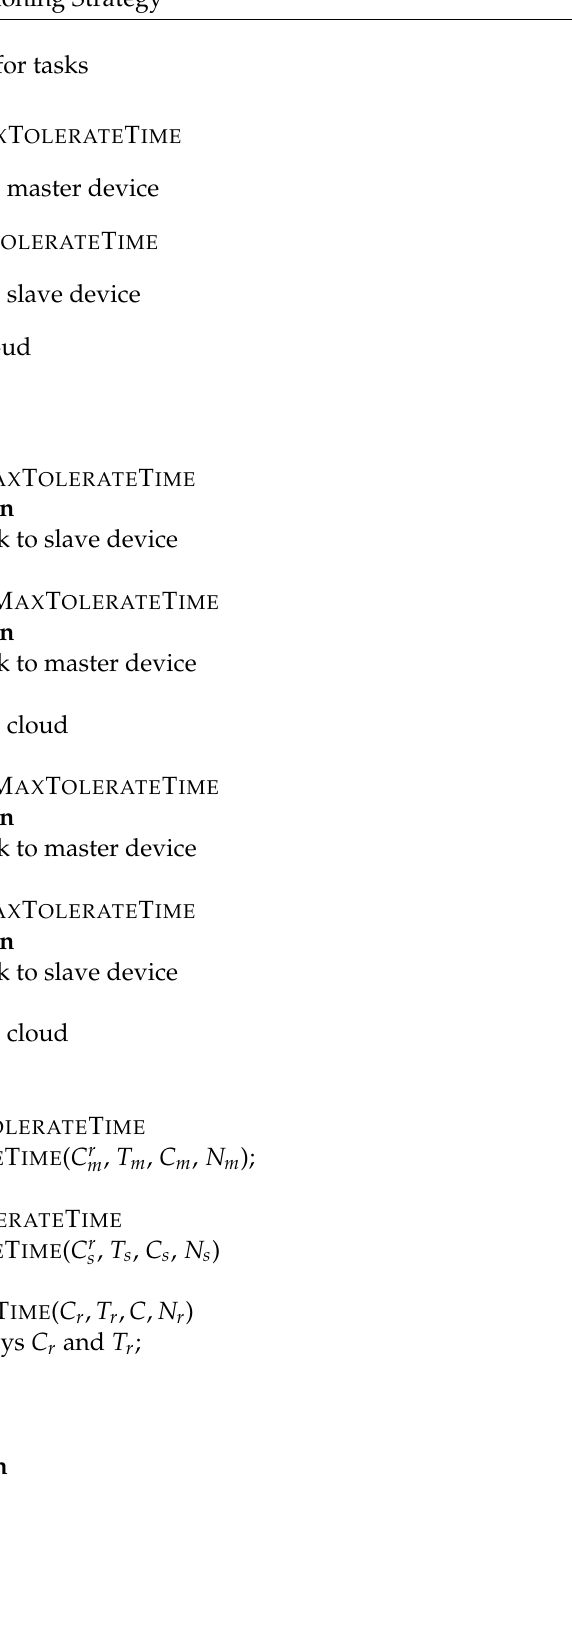
Algorithm 3 Resource Provisioning